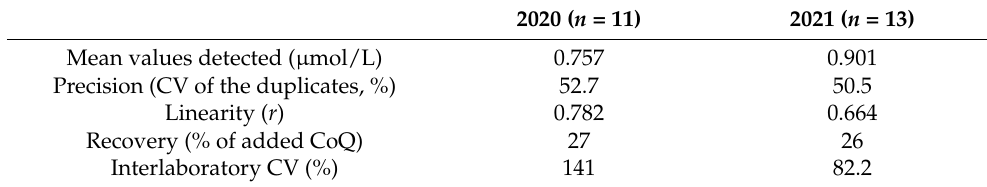
Table 2. Global performance of all participants in the new external quality control (EQC) scheme for the plasma CoQ determination. For different metrological variables, mean values from all participants are provided, which were obtained from the annual reports during the 2020–2021 period. Abbreviations: CV, coefficient of